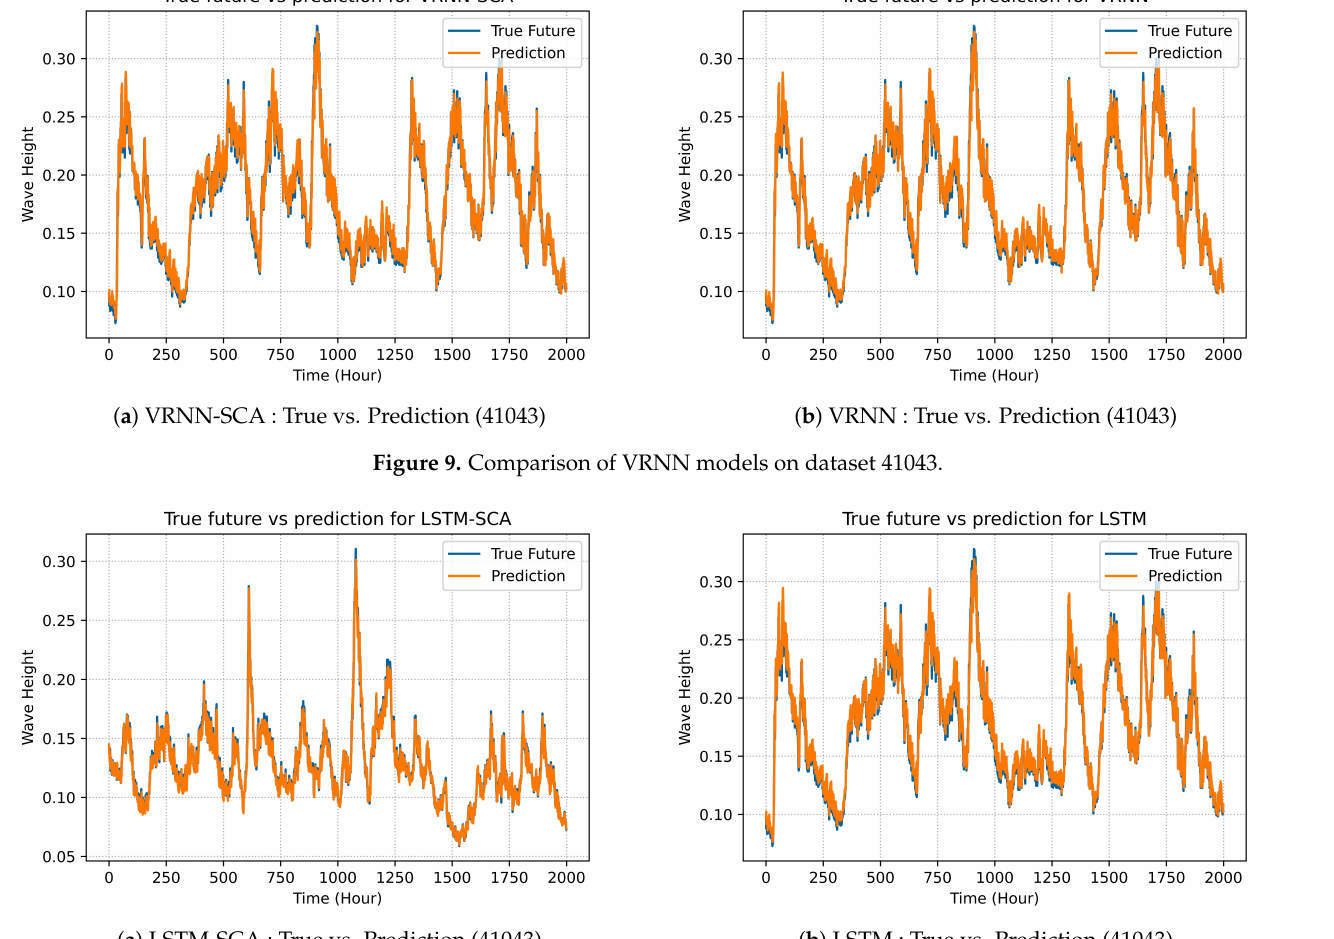
Figure 10. Comparison of LSTM models on dataset